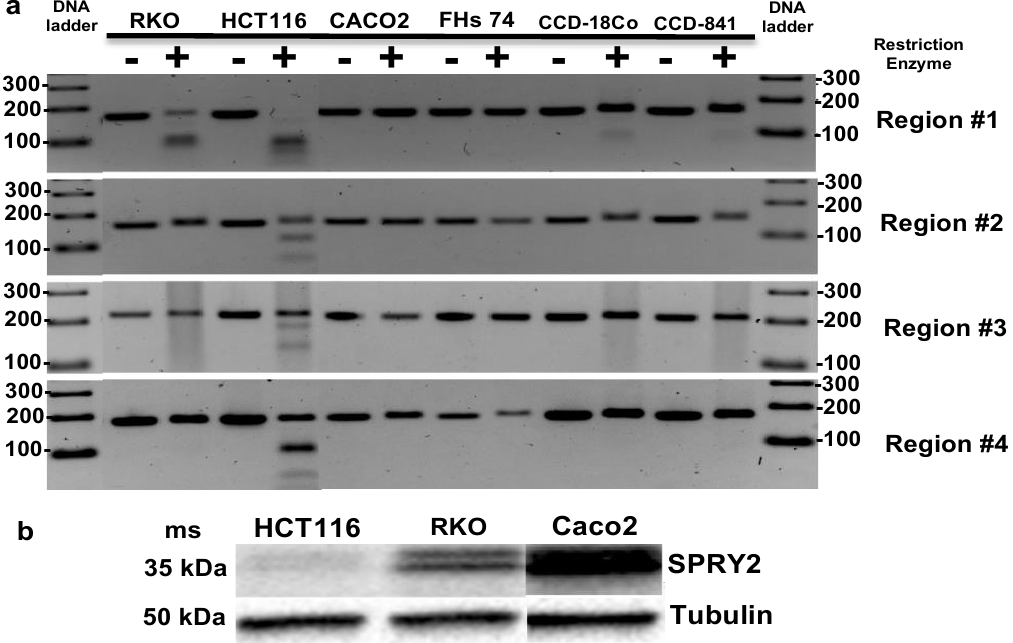
Figure 4. ( a ) COBRA results of 4 regions of interest located in SPRY2 from: 2 CRC cell lines: RKO, HCT116 cells and 3 untransformed colon cell lines: FHC, FHs74, and CCD-841 and 1 fibroblast cell lines CCD-18Co cells. Region #1 shows complete PCR product digestion in HCT116 cells and regions #2, #3, and #4 show partial PCR product digestion, indicating partial methylation in regions #2–#4 and complete methylation in region #1. Region #1 also shows partial methylation in CRC cell lines: RKO and control cell lines: CCD-841 and CCD-18Co. ( b ) Western blot analysis of SPRY2 in 3 colorectal cancer cell